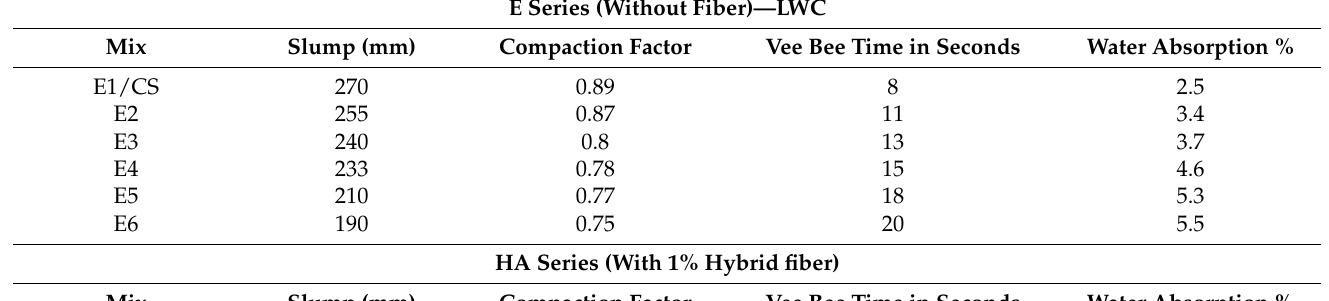
Table 4. Workability test